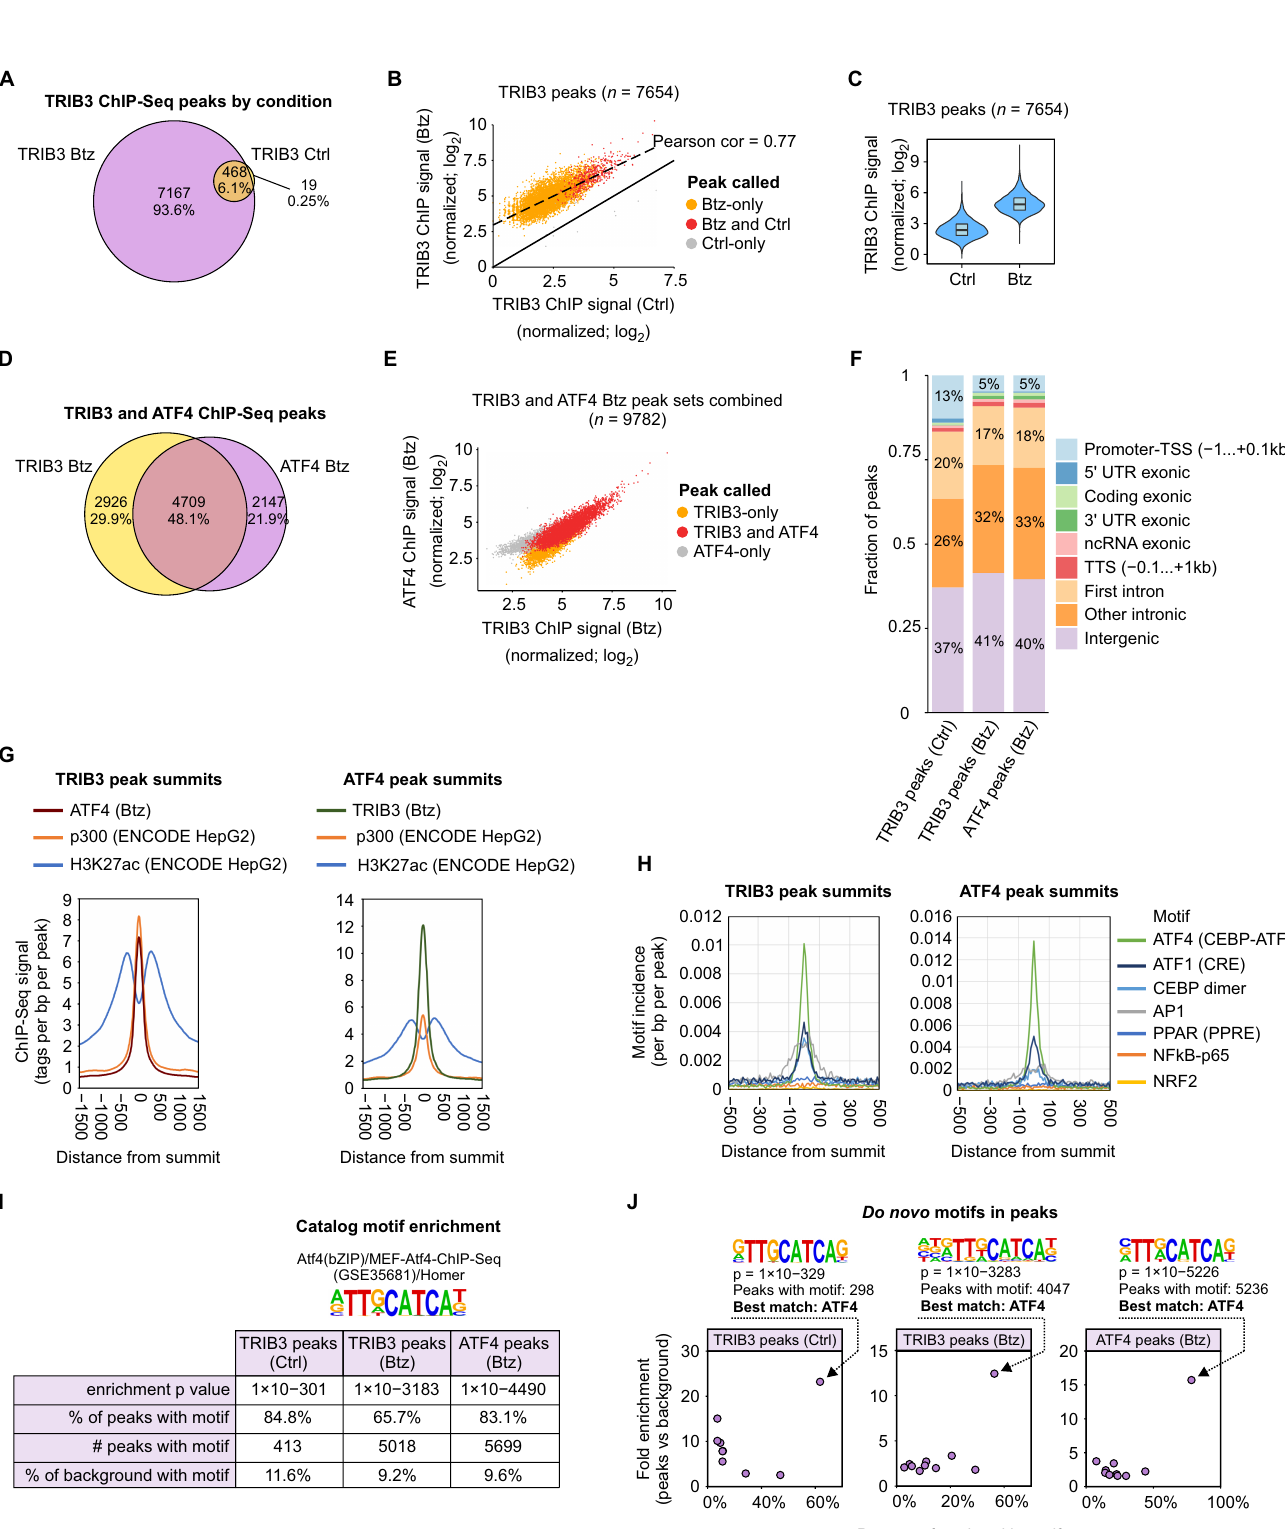
Figure 6. TRIB3 localization to chromatin is highly concordant with the binding pattern of ATF4. For ChIP-Seq, HepG2- TRIB3-Flag cells were treated with 50 nM bortezomib (Btz) for 9 h or mock treated (Ctrl), and chromatin was immunopre- cipitated using anti-Flag or anti-ATF4 antibody. ( A ) Number of TRIB3 chromatin peaks detected per treatment condition. ( B ) TRIB3 ChIP-Seq signal strength at regions detected as TRIB3 peaks either in Ctrl, Btz or both conditions. ( C ) Violin plot of the TRIB3 ChIP-Seq signal strength across all peaks in Ctrl and Btz conditions. ( D ) Overlap of peak regions detected in TRIB3 and ATF4 ChIP-Seq-s in Btz conditions. ( E ) Correlation between TRIB3 and ATF4 ChIP-Seq signal strength in peak regions detected for one or both proteins. ( F ) The genomic context of TRIB3 and ATF4 ChIP-Seq peaks. ( G ) ChIP-Seq